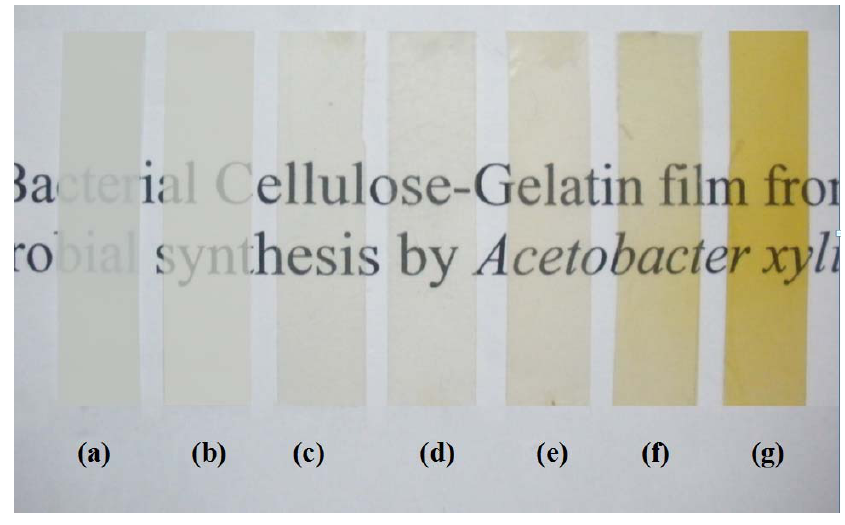
Figure 2. Optical photographs of the BC, BCG and gelatin films: ( a ) BC; ( b ) BCG-1; ( c ) BCG-3; ( d ) BCG-5; ( e ) BCG-7; ( f ) BCG-10 and ( g ) gelatin.